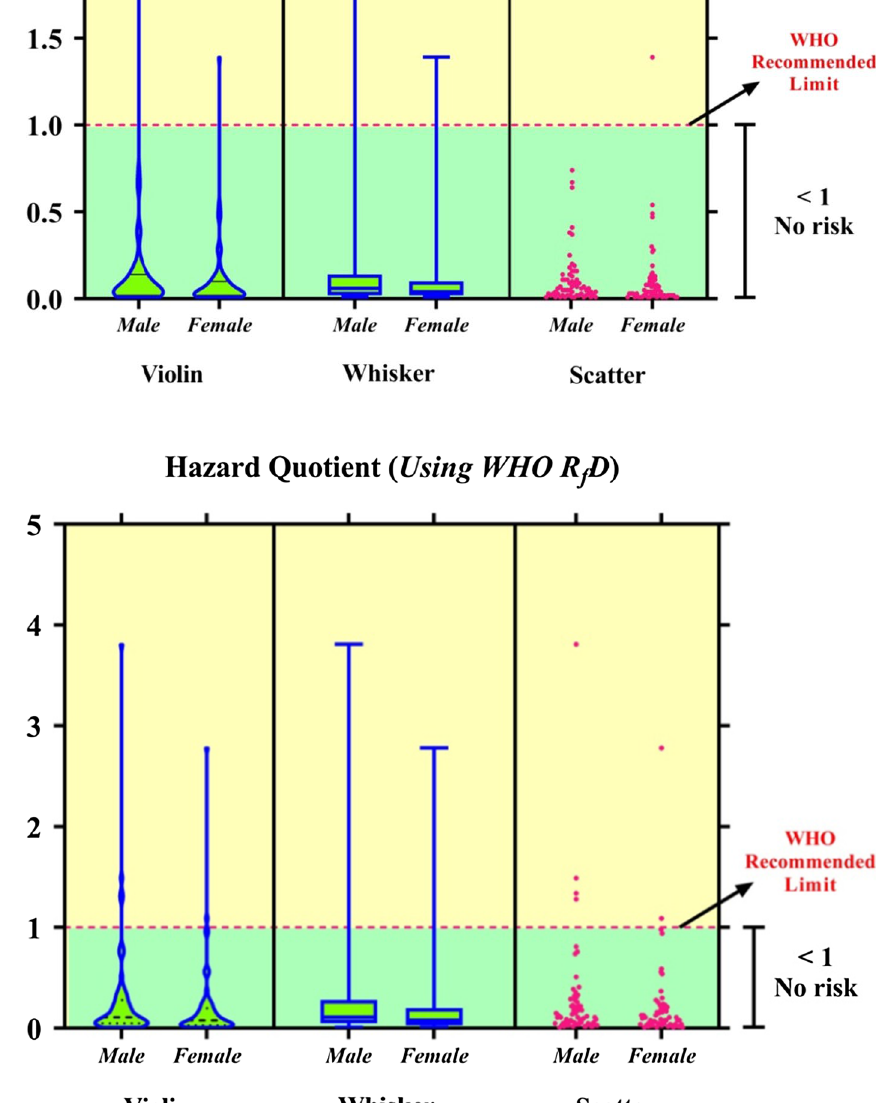
Fig. 17 Frequency distribution of HQ using AERB RfD